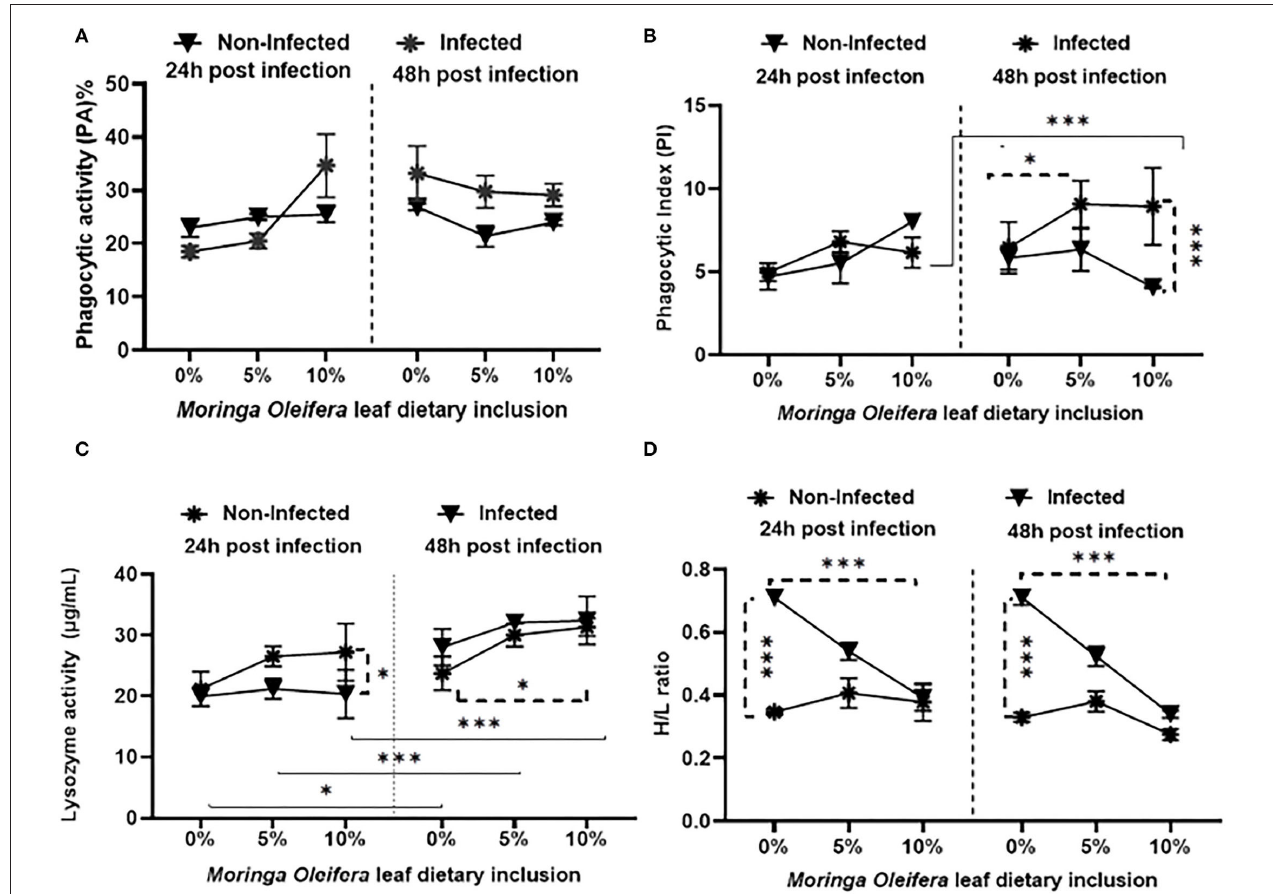
FIGURE 1 | The effect of M. oleifera leaf powder dietary inclusion at 0, 5, and 10% of the diet on immunological parameters under normal health and following 24 and 48h of A. hydrophila infection. (A) Represents the effect of M. oleifera inclusion on phagocytic activity (PA). (B) Shows the effect of moringa on the phagocytic index (PI). (C) Denotes the effect on lysozyme activity. (D) Shows the effect of moringa inclusion on the H/L ratio. Results were shown as means < 0.05 and 0.001,